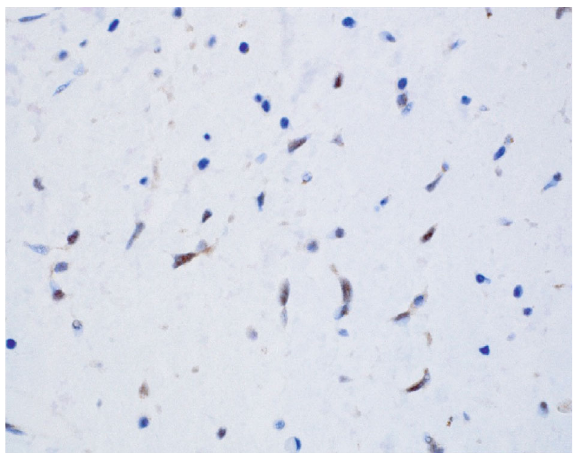
Figure 5: Nuclear STAT-6 positivity at 600 magni fi cation (60x).